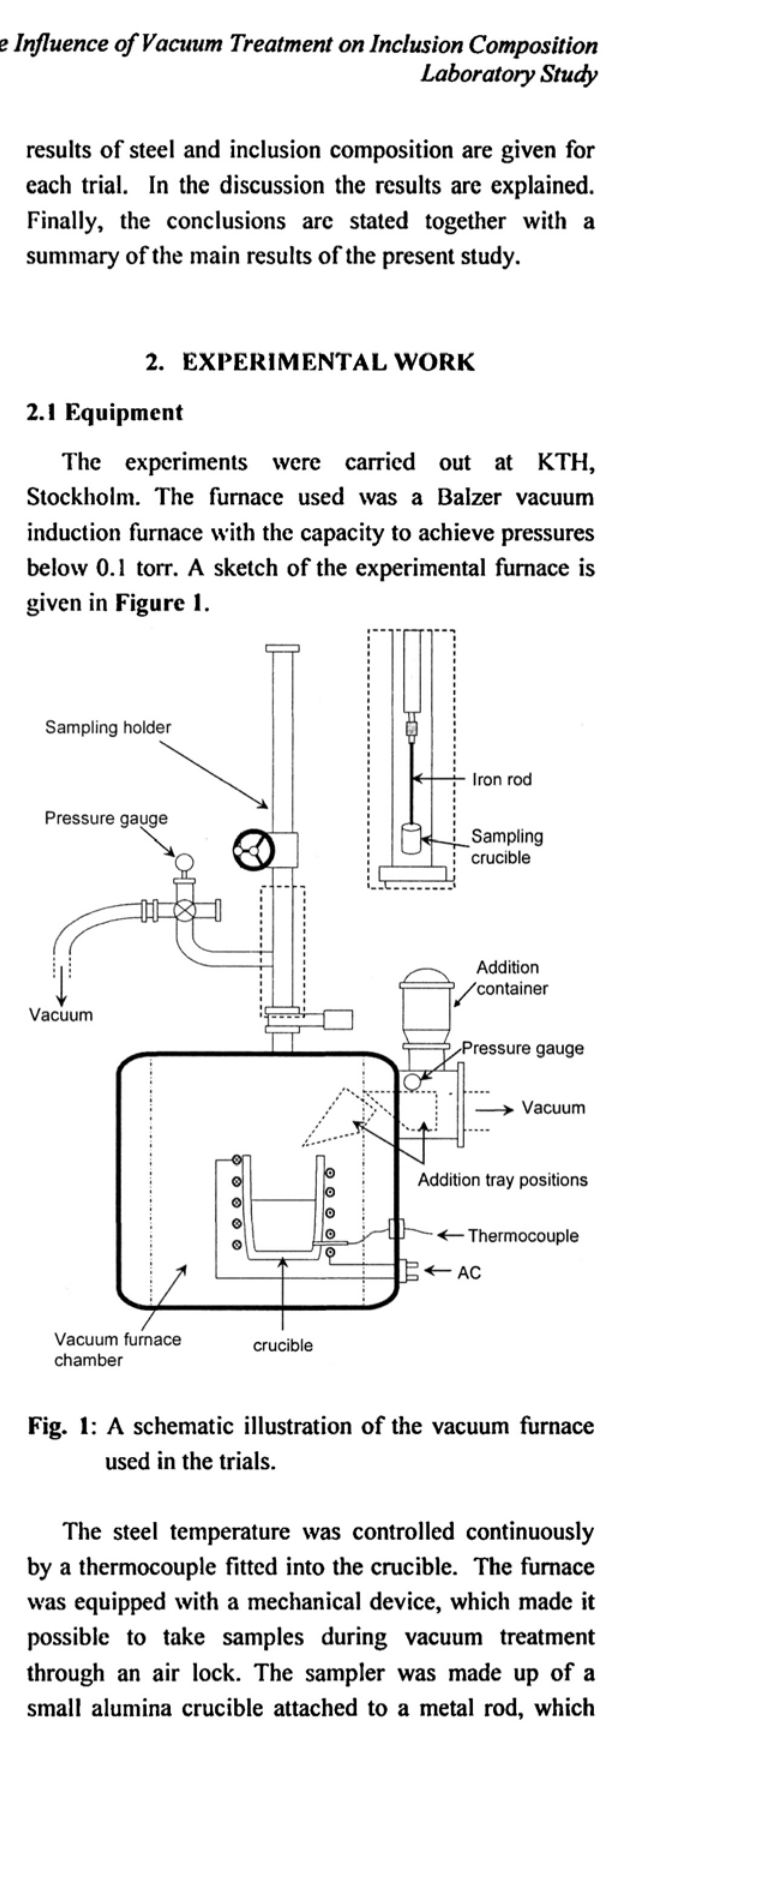
Fig. 1: A schematic illustration of the vacuum furnace used in the